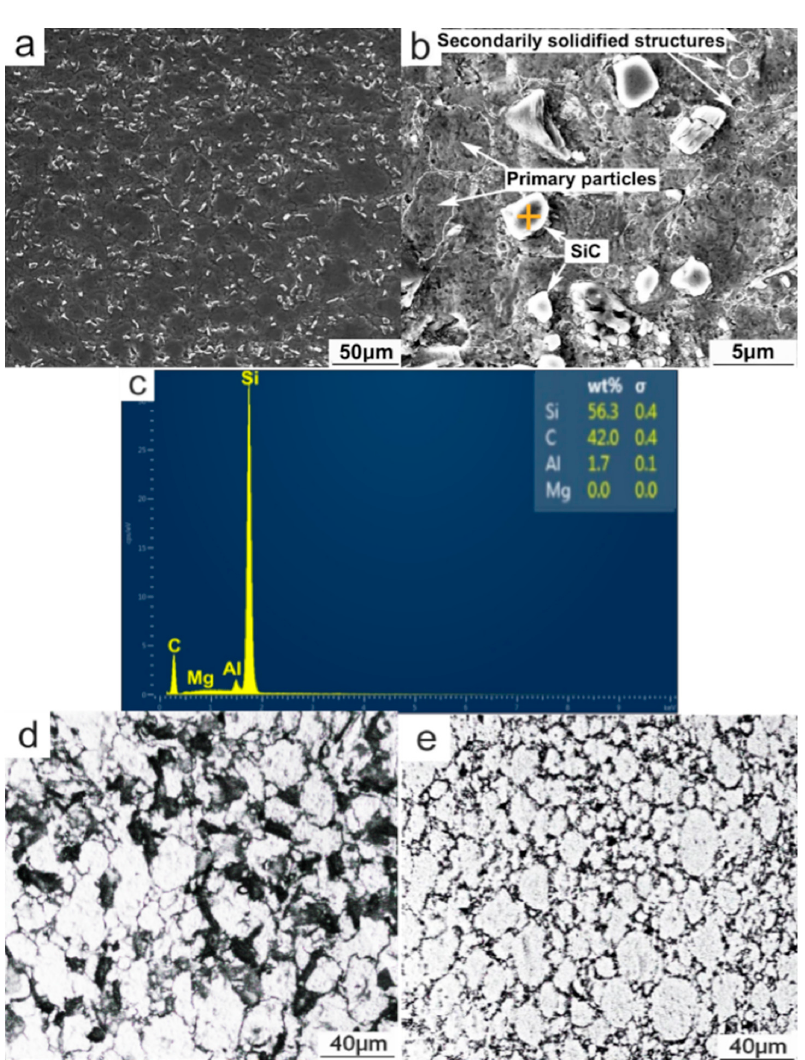
Figure 3. ( a , b ) SEM images of PTF-SiCp/6061Al composite; ( c ) EDS result of the cross in Figure 3b proving the presence of SiCp; ( d ) OM micrograph of PTF-SiCp/6061Al composite; ( e ) OM micrograph of PTF-6061 alloy.